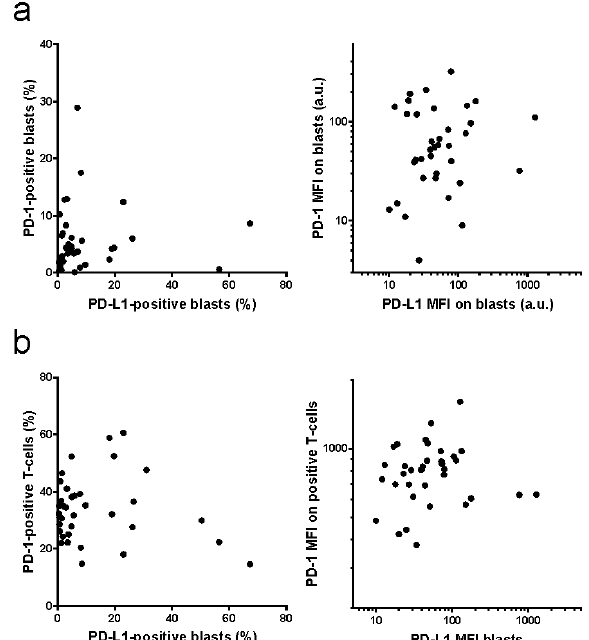
Figure 5. Correlation of PD-L1 and PD-1 expression. PD-L1 expression on AML blasts and PD-1 expression on AML blasts ( a ) or on the autologous T-cells ( b ) was determined by flow cytometry. Left: positive cell fractions, right: mean fluorescence intensity (MFI).